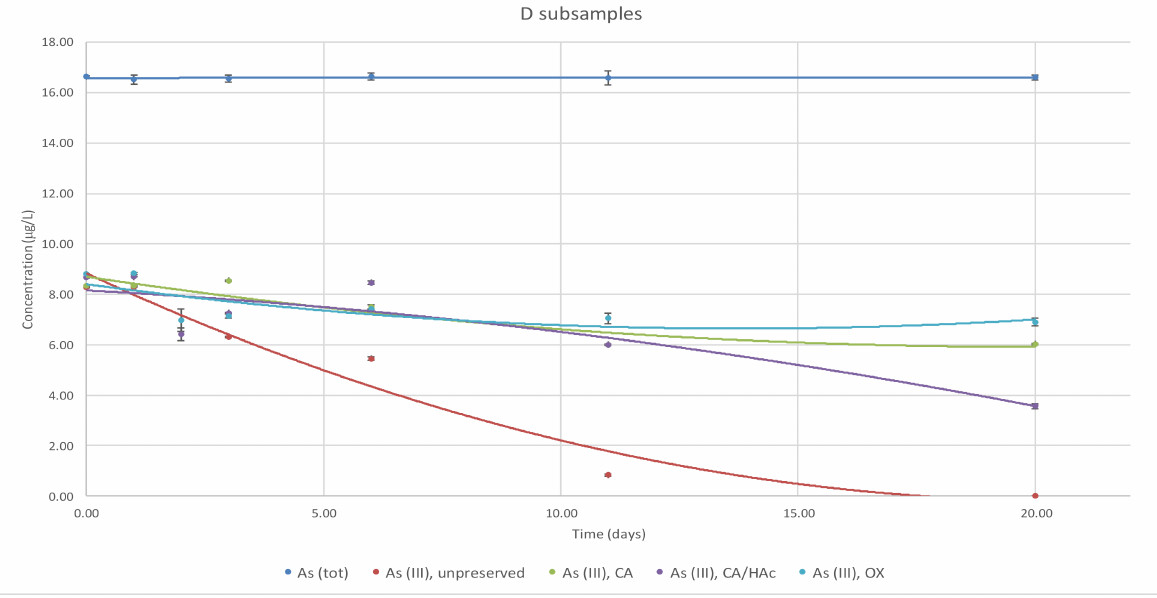
Figure 7. As(III) and As(tot) stability over time, dependent on the preservation treatment used—natural water sample